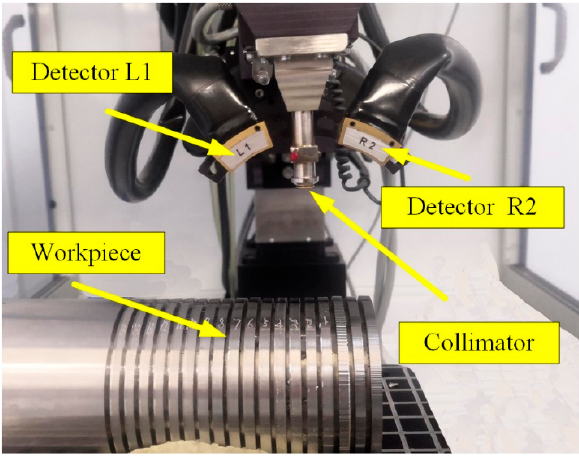
Figure 3. Residual stress measurement process. Table 3. The parameters used in residual stress measurements.